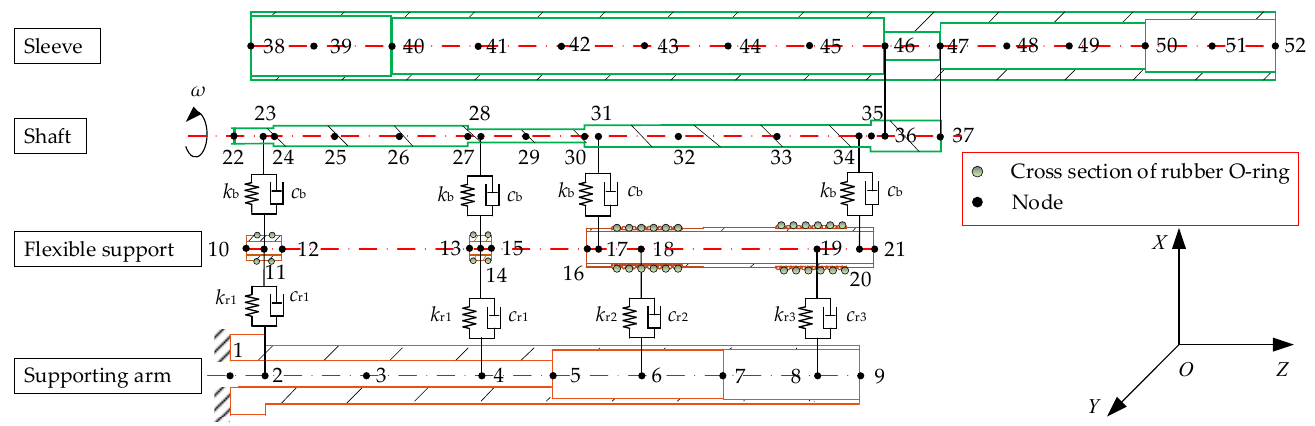
Figure 3. Finite element model of the winding rotor.